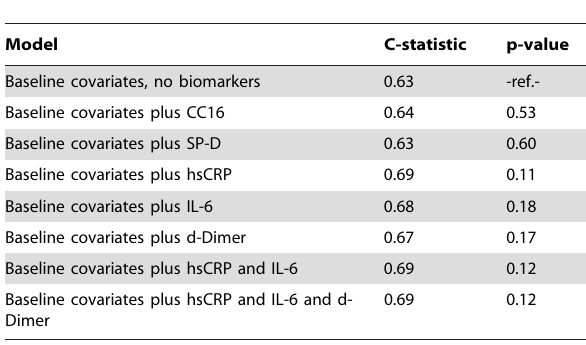
Table 5. C-statistics for receiver-operating characteristic analyses of baseline covariates alone and with addition of baseline